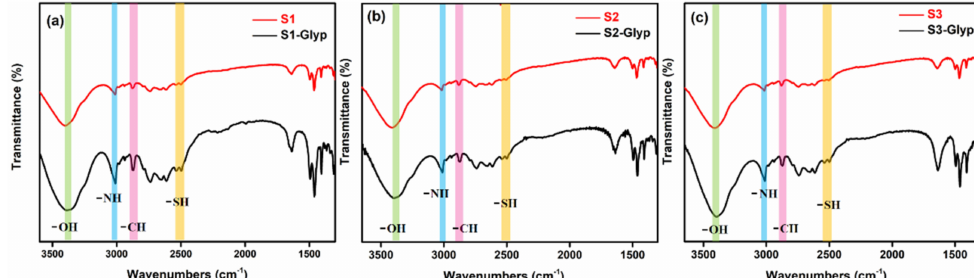
Figure 4. FT-IR spectra of AET-AuNP chemical sensors S1 ( a ), S2 ( b ) and S3 ( c ) dispersions (red) and aggregates (black) in the presence of 5 mM glyphosate (KBr